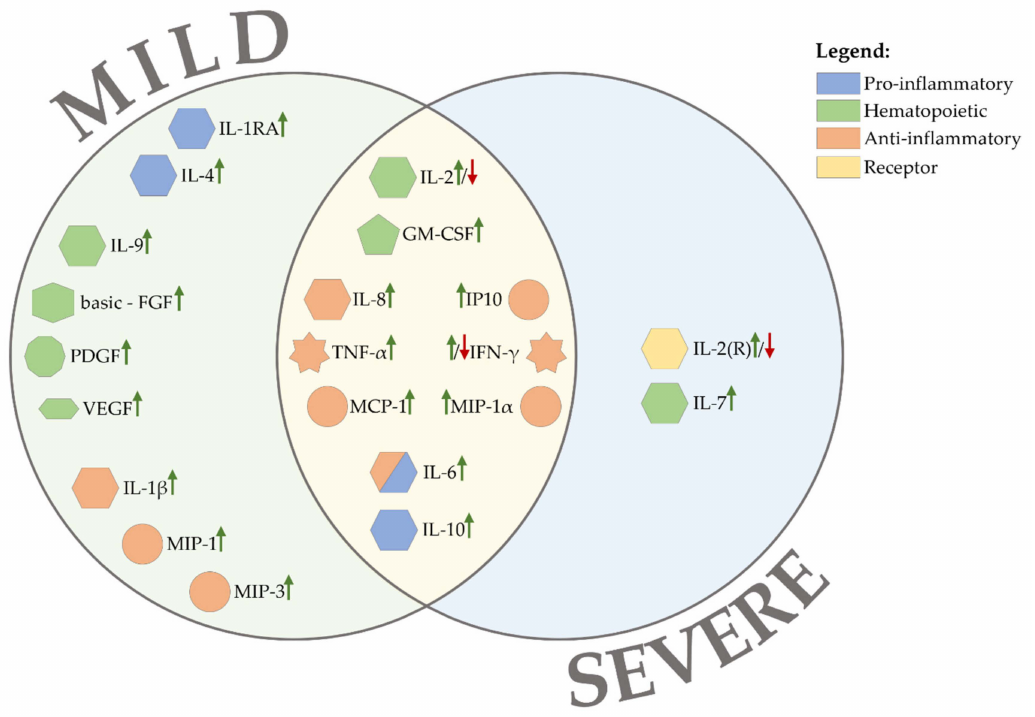
Figure 2. Cytokine levels change in COVID-19 patients depending on the patient’s